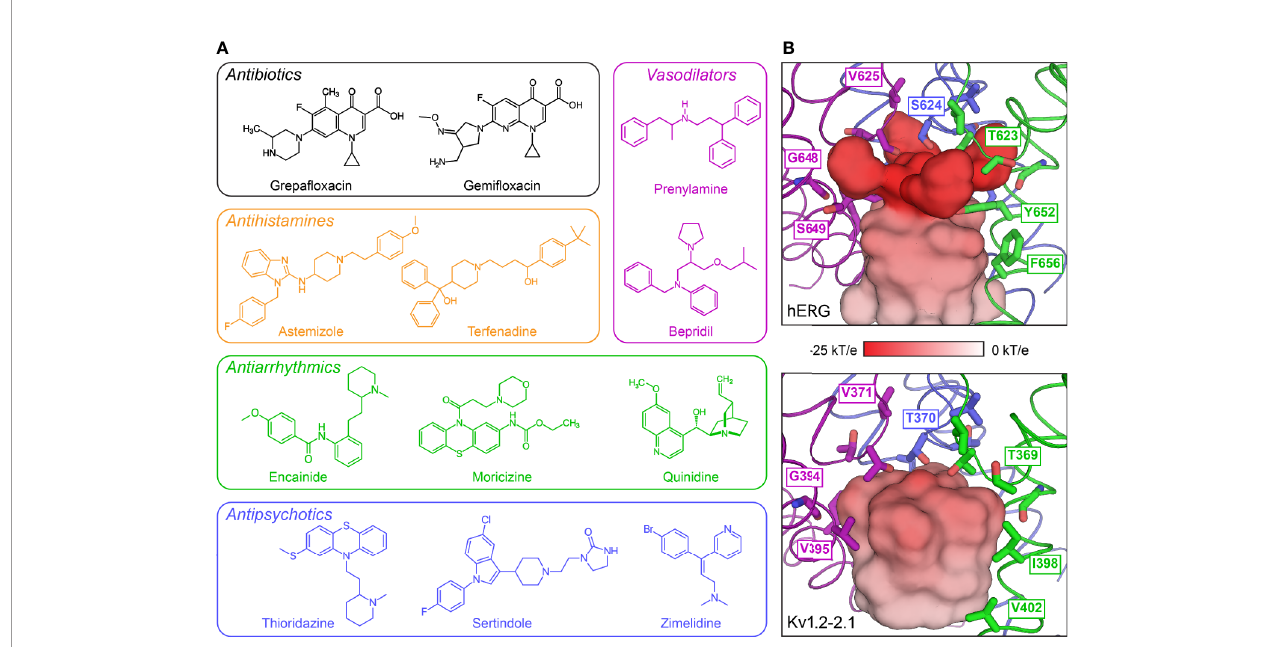
FIGURE 12 | Structural features of the drug-binding cavity of the hERG channel pore. (A) Examples of drugs discontinued by the US FDA because of side effects related to hERG inhibition (adapted from Table 1 in (Kalyaanamoorthy and Barakat, 2018)). (B) Internal molecular surface of the central cavity below the SF in hERG (PDB: 5VA1)(Wang and Mackinnon, 2017) (top) and the K V 1.2 – 2.1 chimeric channel (PDB: 2R9R)(Long et al., 2007) (bottom). The surface is colored by the electrostatic potential calculated with the APBS tool in PyMOL (The PyMOL Molecular Graphics System, Version 2.2 Schrödinger, LLC.). Residues related to drug binding by hERG and the corresponding residues in the K V 1.2 – 2.1 structure are shown as sticks. This panel is inspired by Figure 5 in (Wang and Mackinnon,